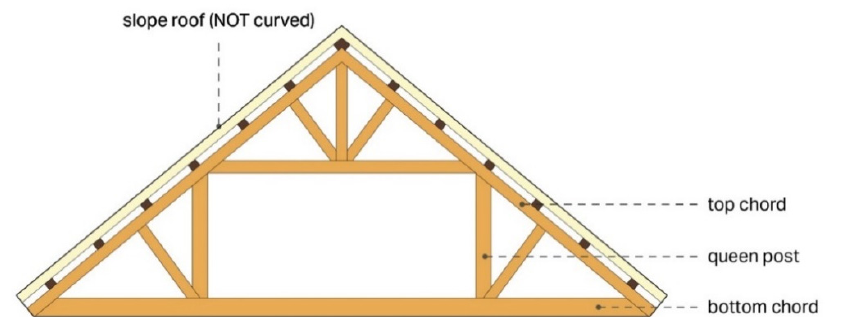
Figure 8. Western Queen Truss (Chungang High School, 1917).